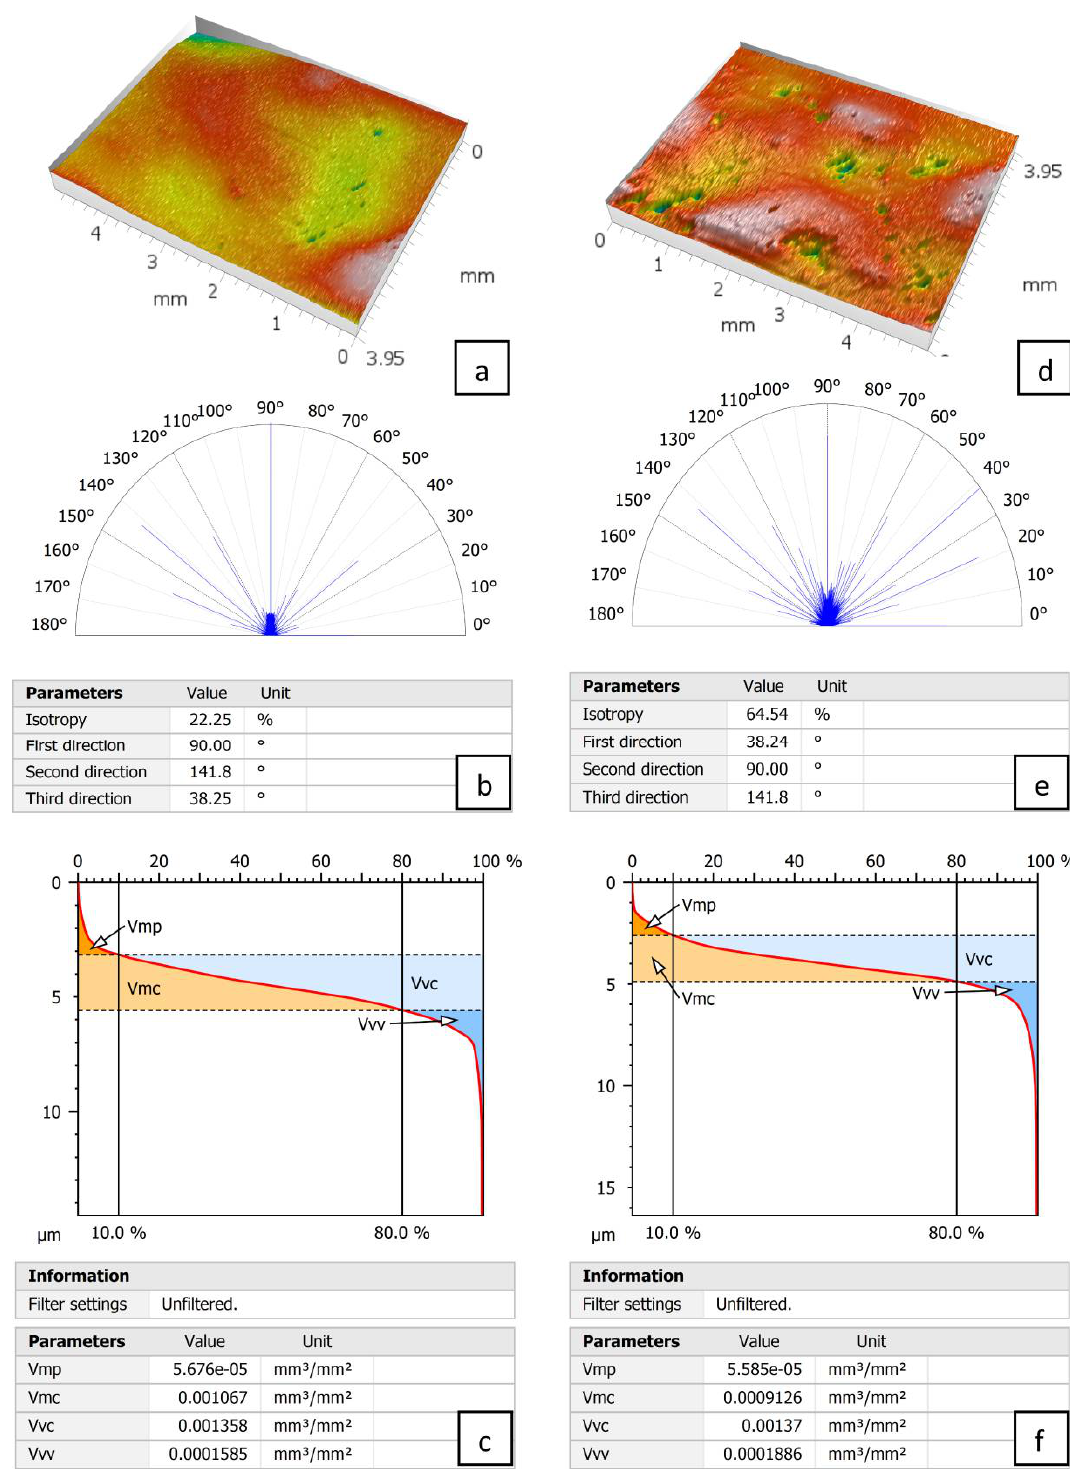
Figure 9. Analysis of the 0° slope surface after 48 h working time: false color map ( a ), isotropy analysis ( b ), and functional analysis ( c ). Analysis of the same slope after 48 h with a slow rotational speed of the barrel: false color map ( d ), isotropy analysis ( e ), and functional analysis ( f ).